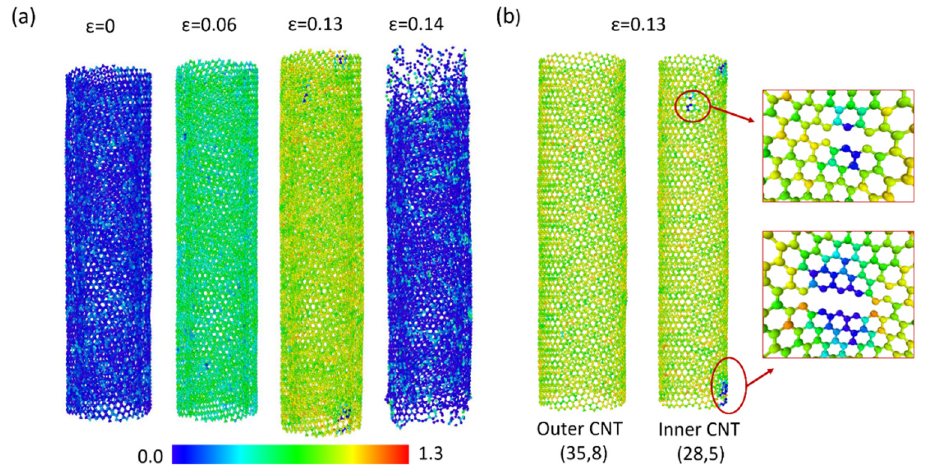
Figure 2. ( a ) CNT stress field changes with the strain for DWNT-Al. ( b ) Stress field and bond breakage at the fracture strain. The color bar represents the magnitude of the atomic stress in 10 3 GPa A 3